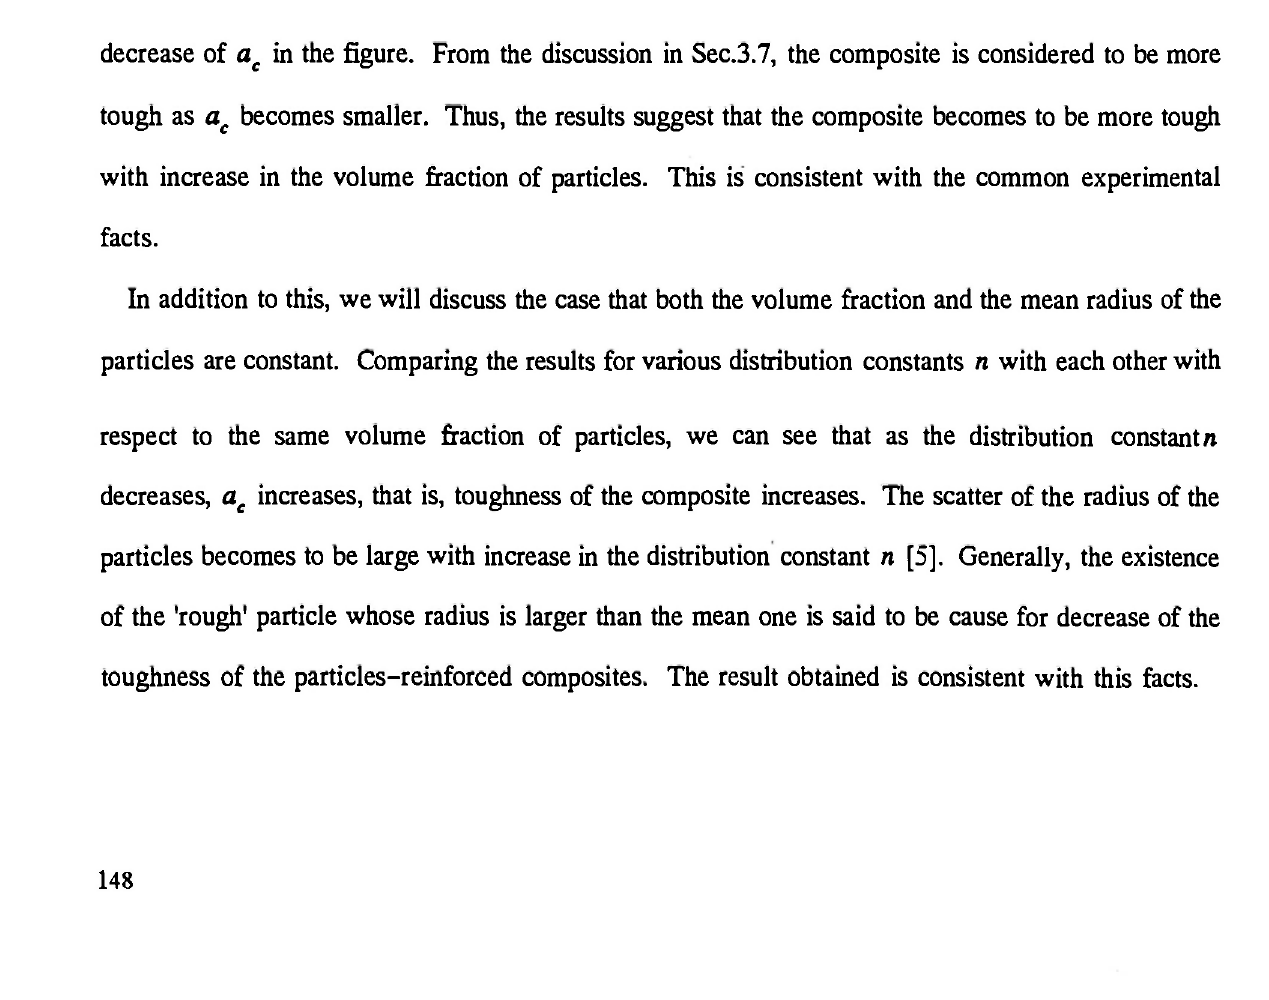
Fig.6 Critical crack length a c / r versus volume fraction of particles